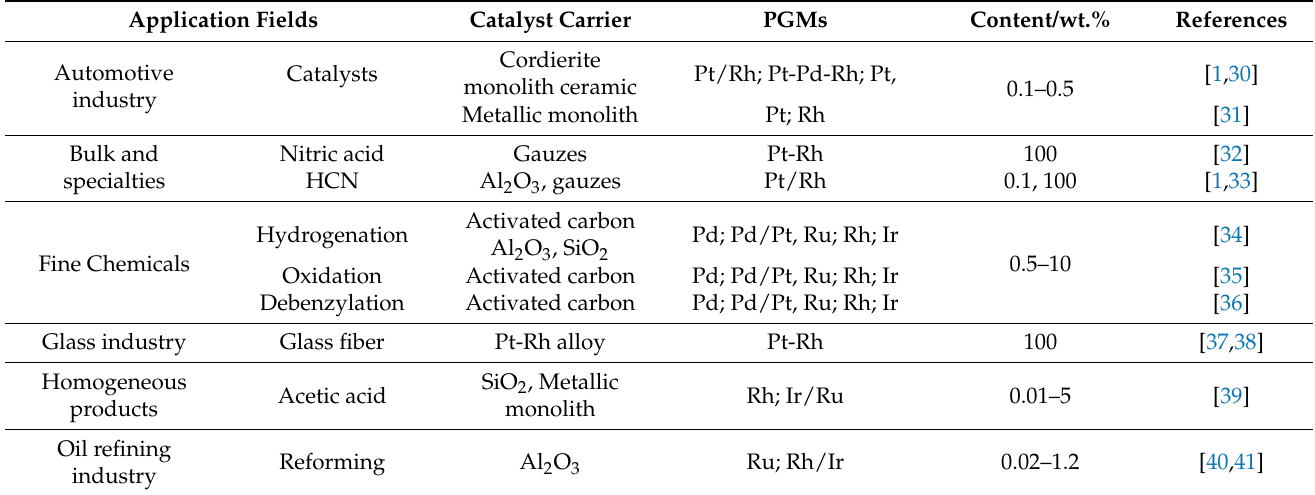
Figure 2. Average Rh price trend 2002–2022 (USD/oz). Table 1. Composition of different types of spent catalysts in various applications .